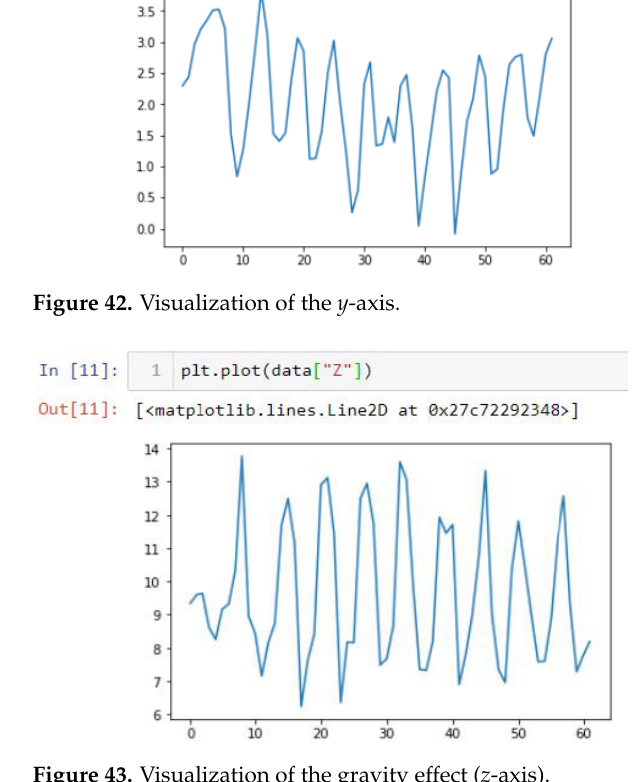
Figure 43. Visualization of the gravity effect ( z -axis).